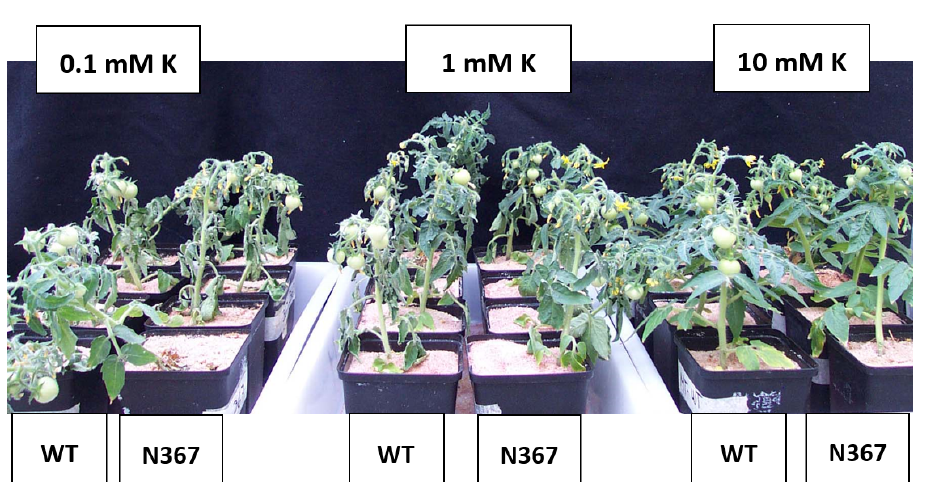
Figure 1. Plants of tomato lines WT and N367 growing with 0.1 ( left ), 1 ( center ) or 10 mM K ( right ) after withholding irrigation for two weeks.